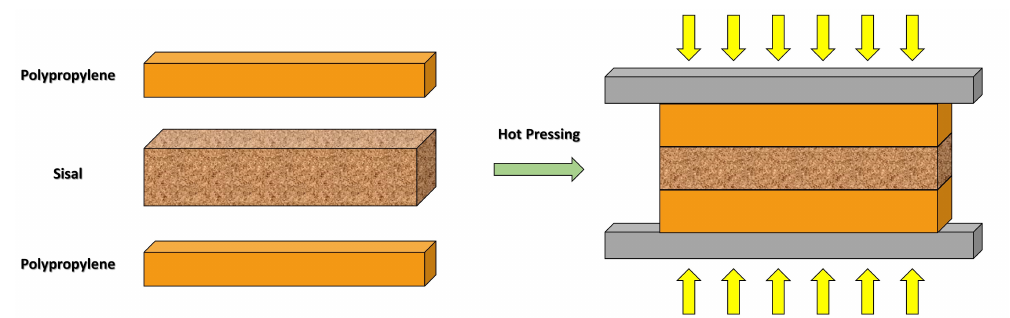
Figure 1. Scheme of the mat with a three-layer sandwich structure for composite preparation by compression